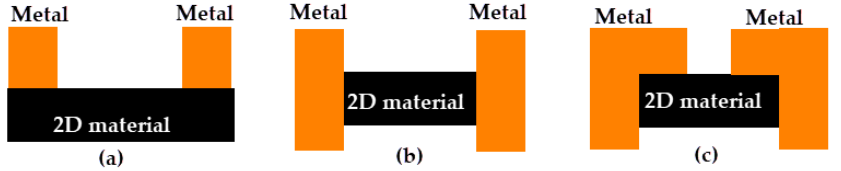
Figure 2. ( a ) traditional top-contacted; ( b ) edge/one dimensional-contacted; ( c ) sandwich/combined-contacted.